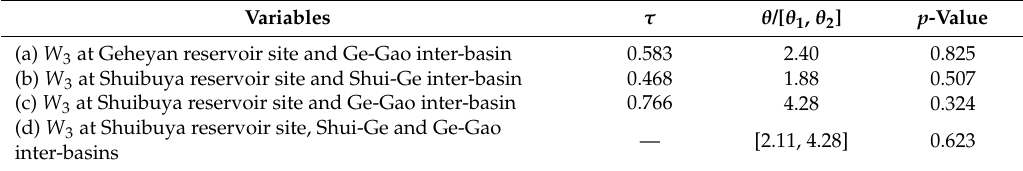
Table 3. Estimated parameters of the G-H copula function and Cramer-von Mises test.